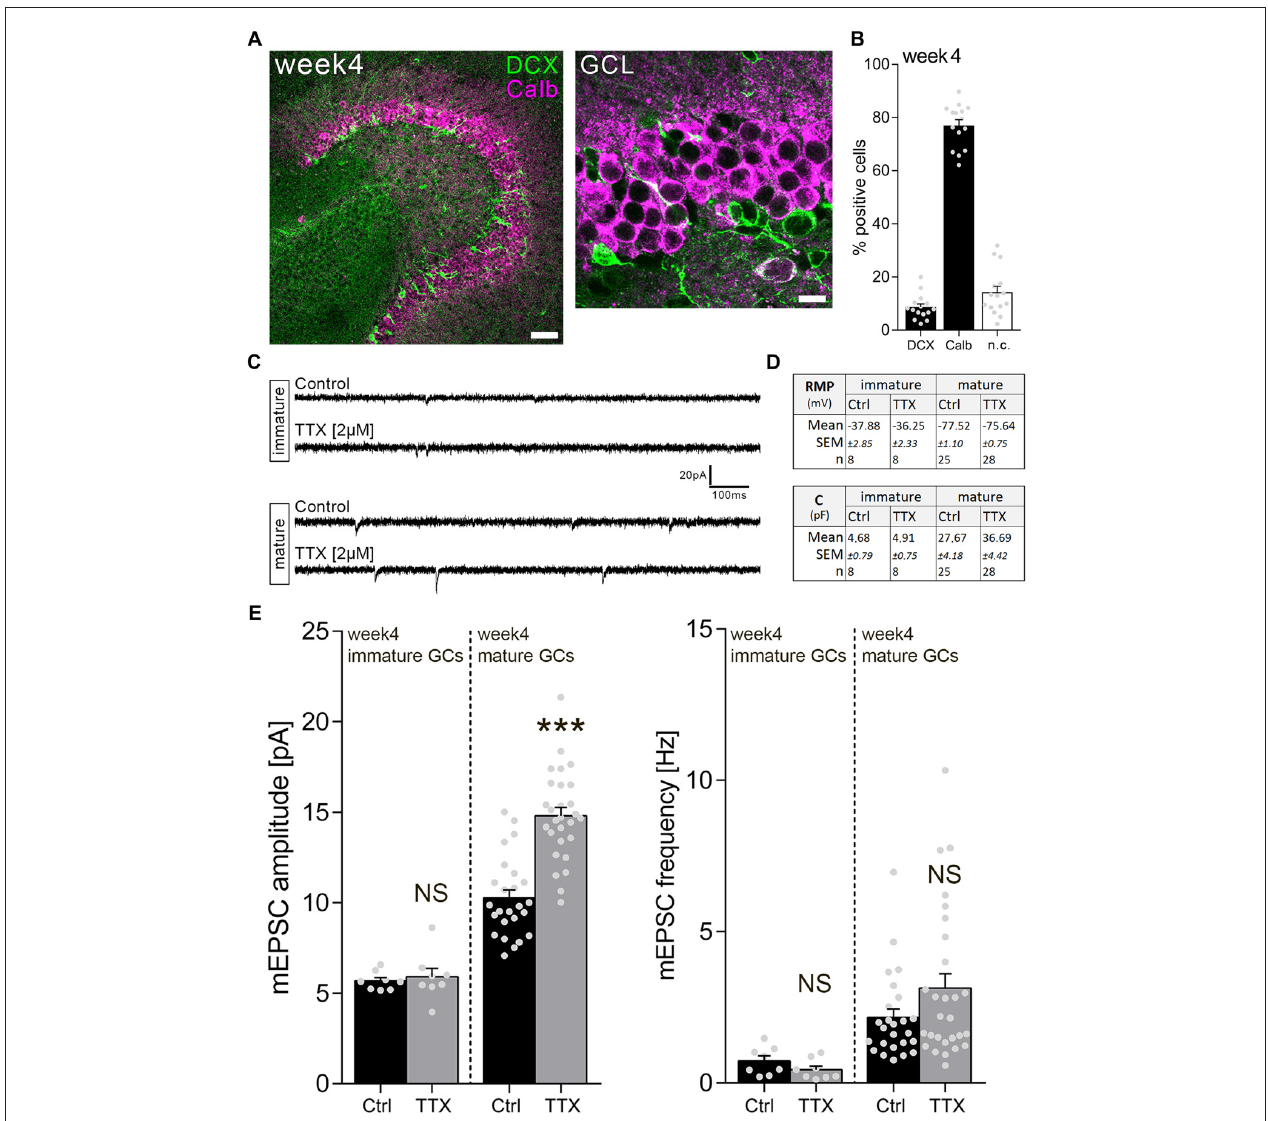
FIGURE 3 | Immature dentate GCs of 4-week-old slice cultures do not express homeostatic excitatory synaptic plasticity. (A) Example of a 4-week-old entorhino-hippocampal slice culture stained for Calb (magenta) and DCX (green). The GCL is shown at higher magnification. Scale bars, 50 µ m and 10 µ m. (B) Quantification of DCX and Calb expression in 4-week-old slice cultures. Some cells expressed both or neither of the markers (n.c., not classified; n = 15 cultures per group). (C) Sample traces of AMPA receptor-mediated mEPSCs recorded from GCs in TTX (2 µ M, 3 days) and vehicle-only (control)-treated cultures. (D) Resting membrane potential (RMP) and capacitance of immature and mature GCs were not changed after TTX treatment (Mann-Whitney test). (E) Group data of mEPSC recordings (amplitudes and frequencies) from immature and mature GCs of vehicle-only (Ctrl, control) and TTX-treated cultures (immature: n control = 8